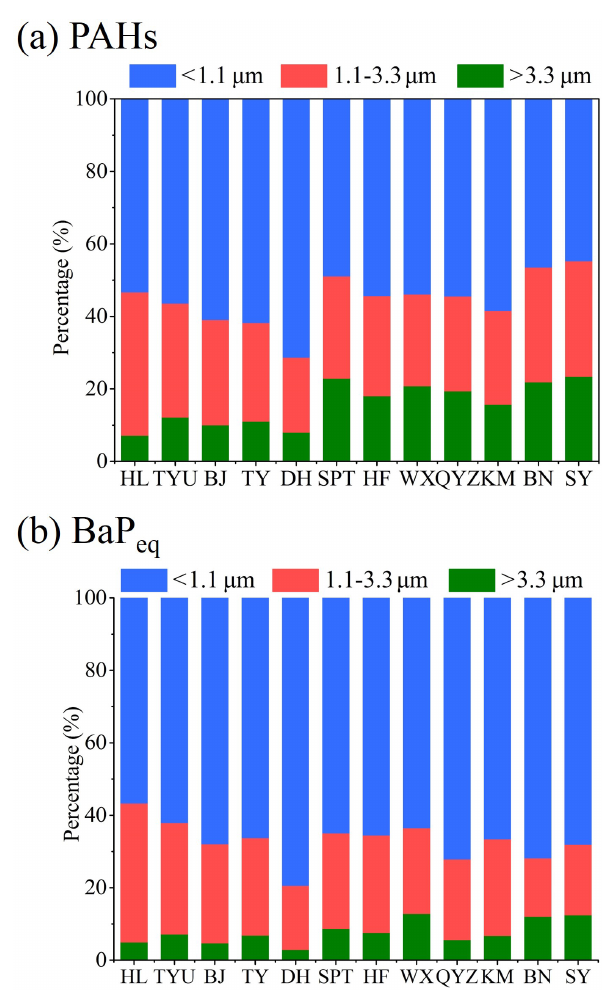
Figure 2. Size distribution of total measured PAHs (a) and BaP eq (b) at 12 sites over China.